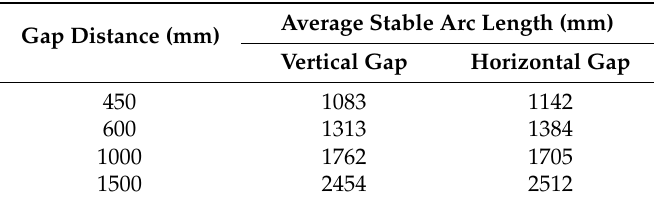
Table 1. Average stable arc length of arcing horns at different configurations.